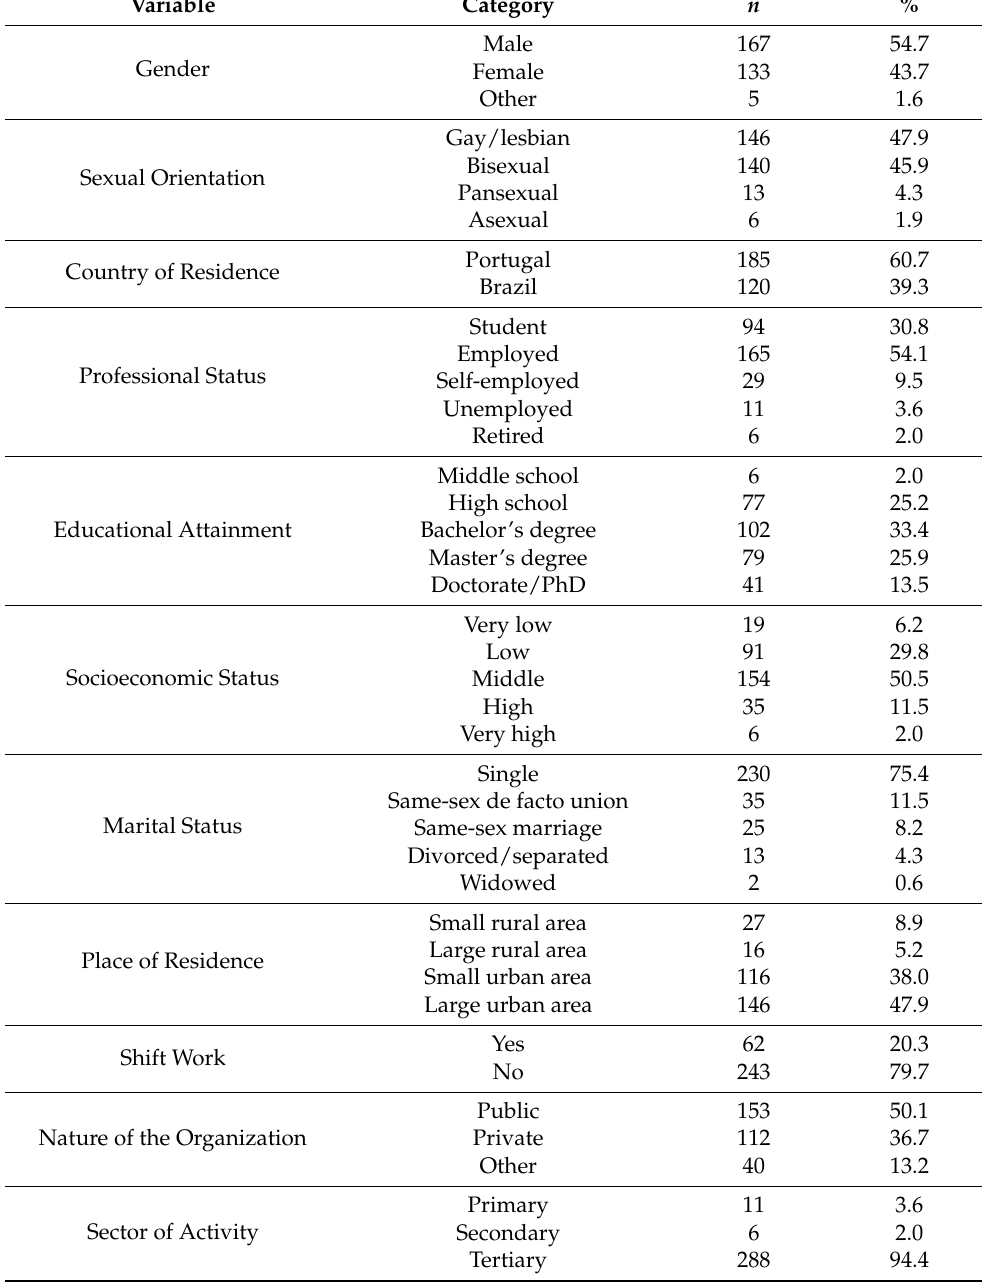
Table 1. Sociodemographic characteristics ( M age = 31.97; SD =